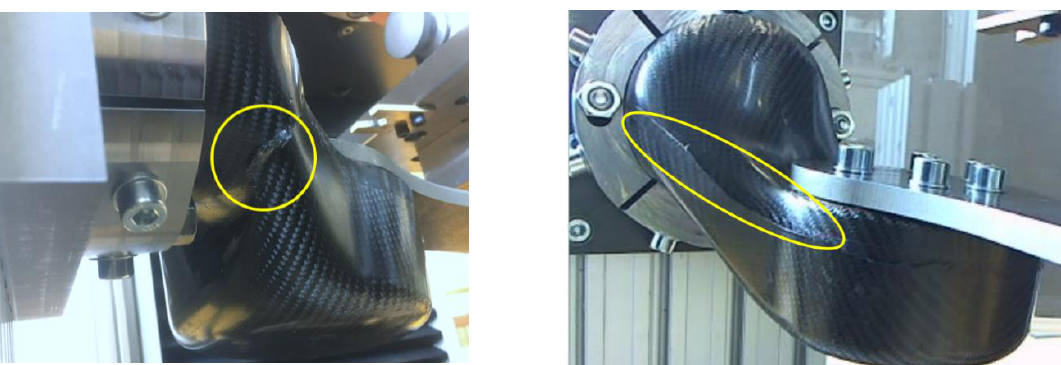
Figure 16. Observed failure modes from the two-point bending test.